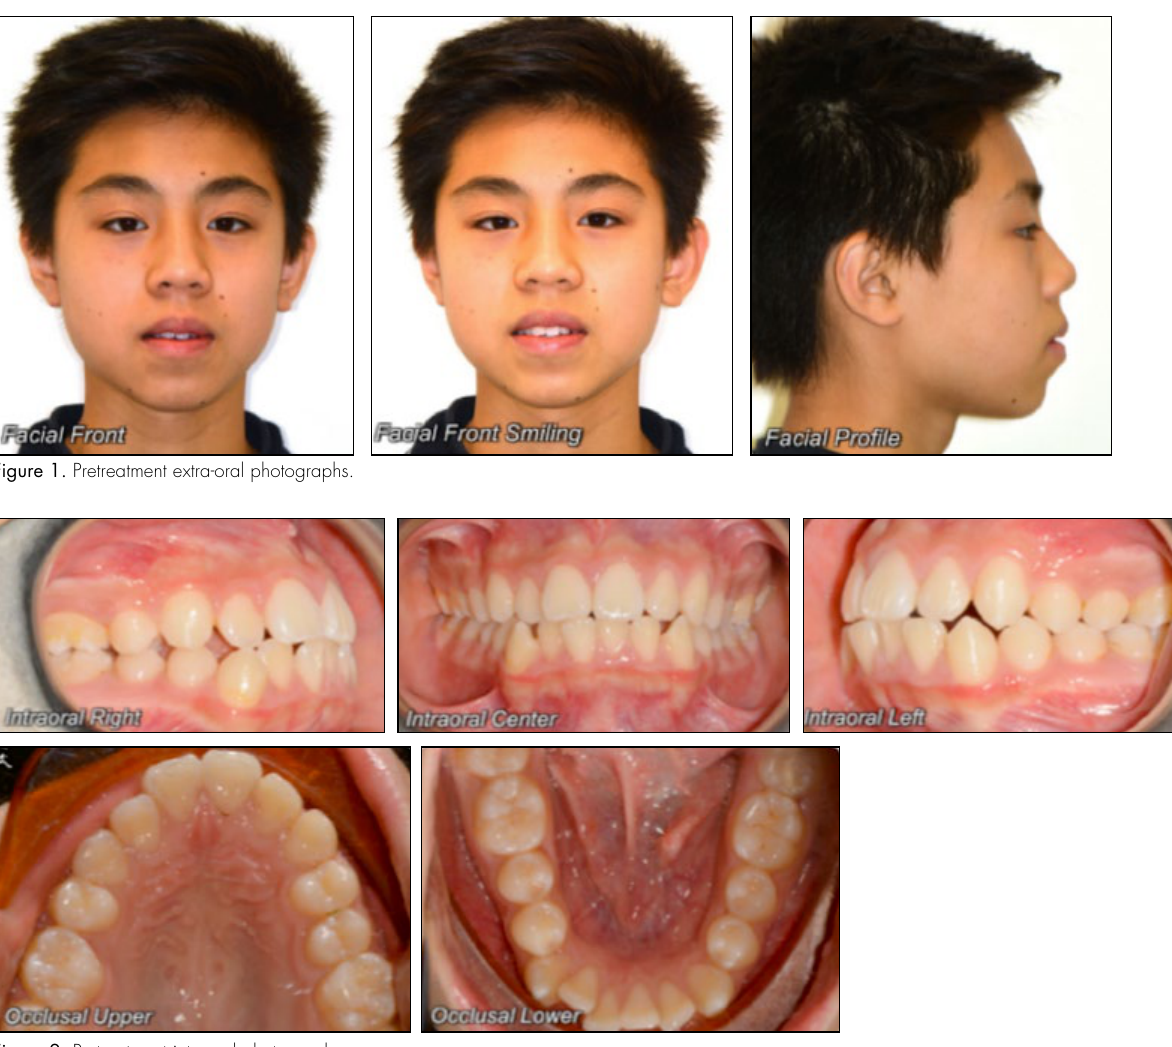
Figure 2. Pretreatment intraoral photographs.